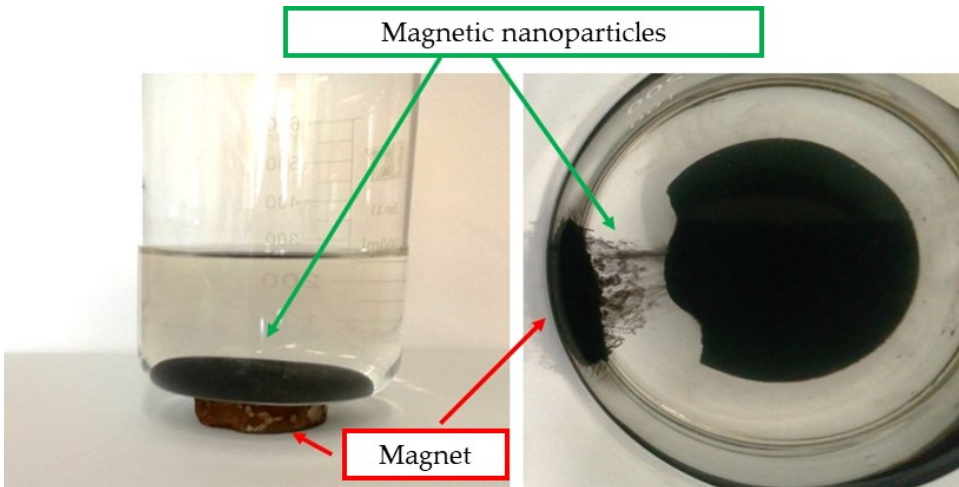
Figure 2. Images showing the behavior of the nanoparticles under the influence of the magnetic field applied.